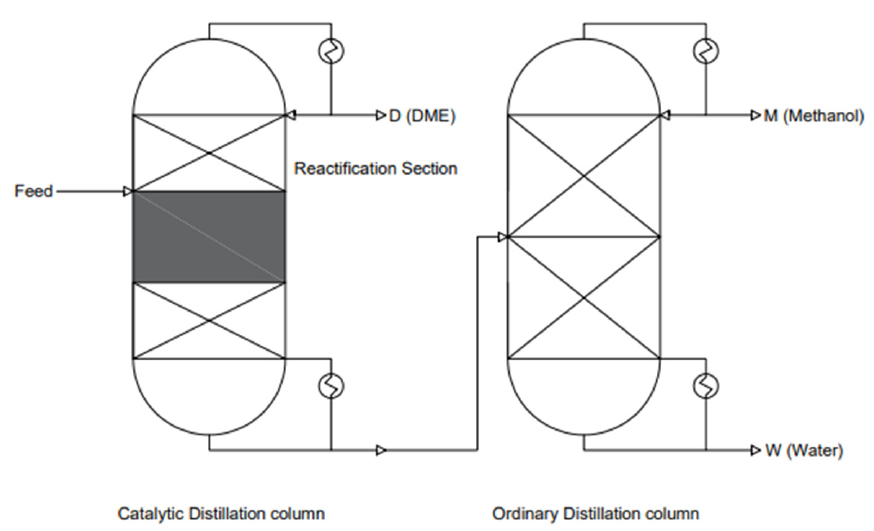
Figure 16. Catalytic distillation column and an ordinary distillation column. Developed based on [101]. (e) Reactor with a spherical membrane